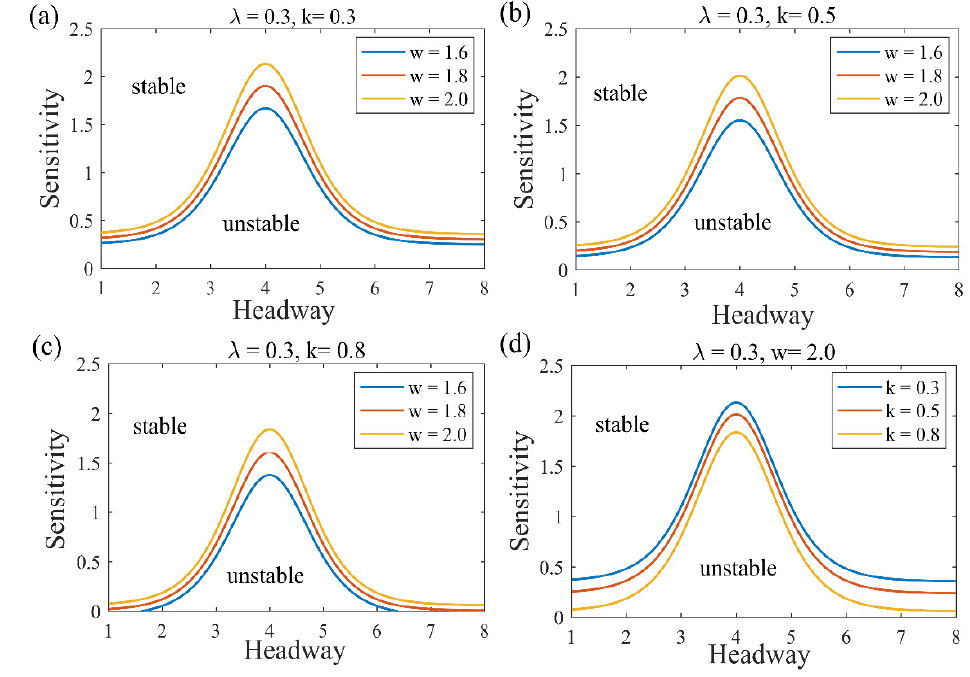
λ k and λ k and .